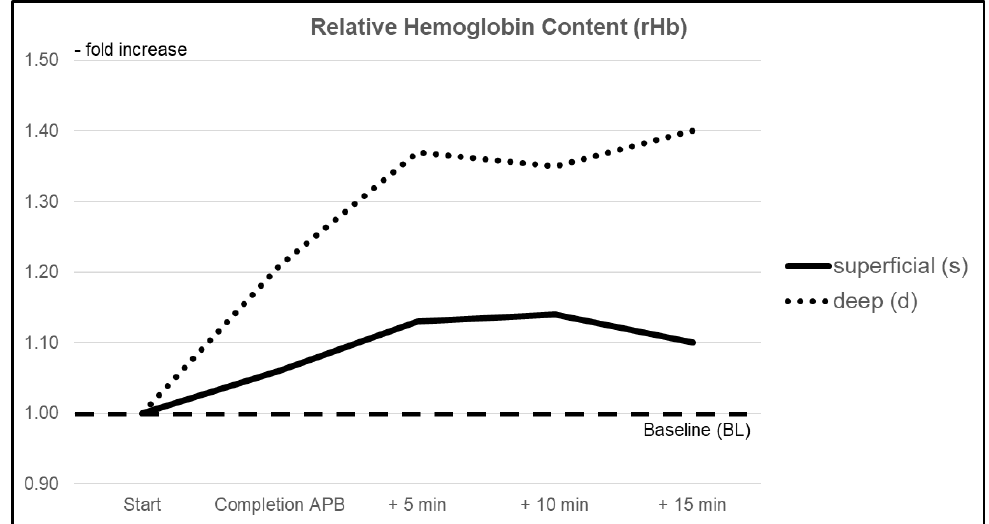
Figure 4. Relative changes in mean relative hemoglobin content (rHb) within superficial (pulp) and deep (thenar eminence) tissue layers over the duration of the investigation.